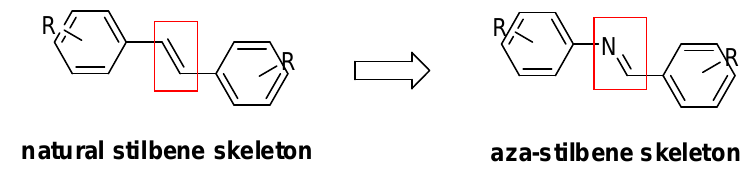
FIGURE 2. Classical bioisosterism